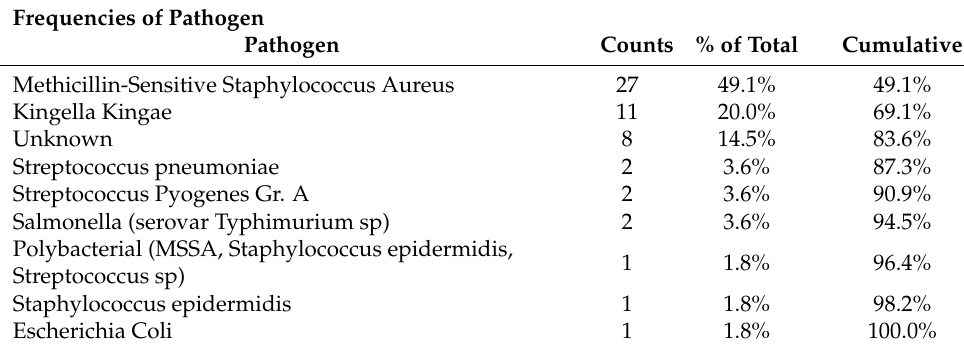
Table 2. Pathogen frequencies.